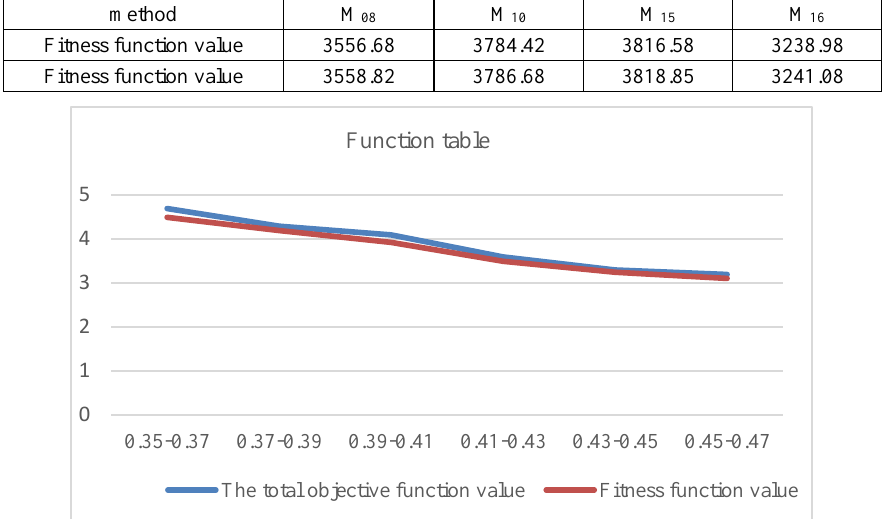
Fig. 1. Calculated results of different high-speed sections.